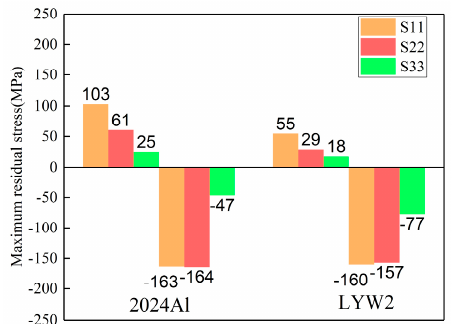
Figure 17. Maximum stresses of as-quenched 2024Al and W/2024Al blocks with thickness of 18 mm.